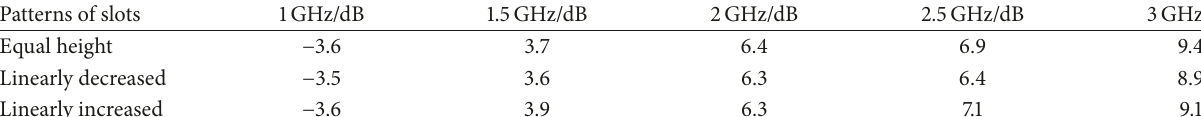
Table 3: Influence of different patterns of slots on gain in the 𝑦 direction at different frequencies.